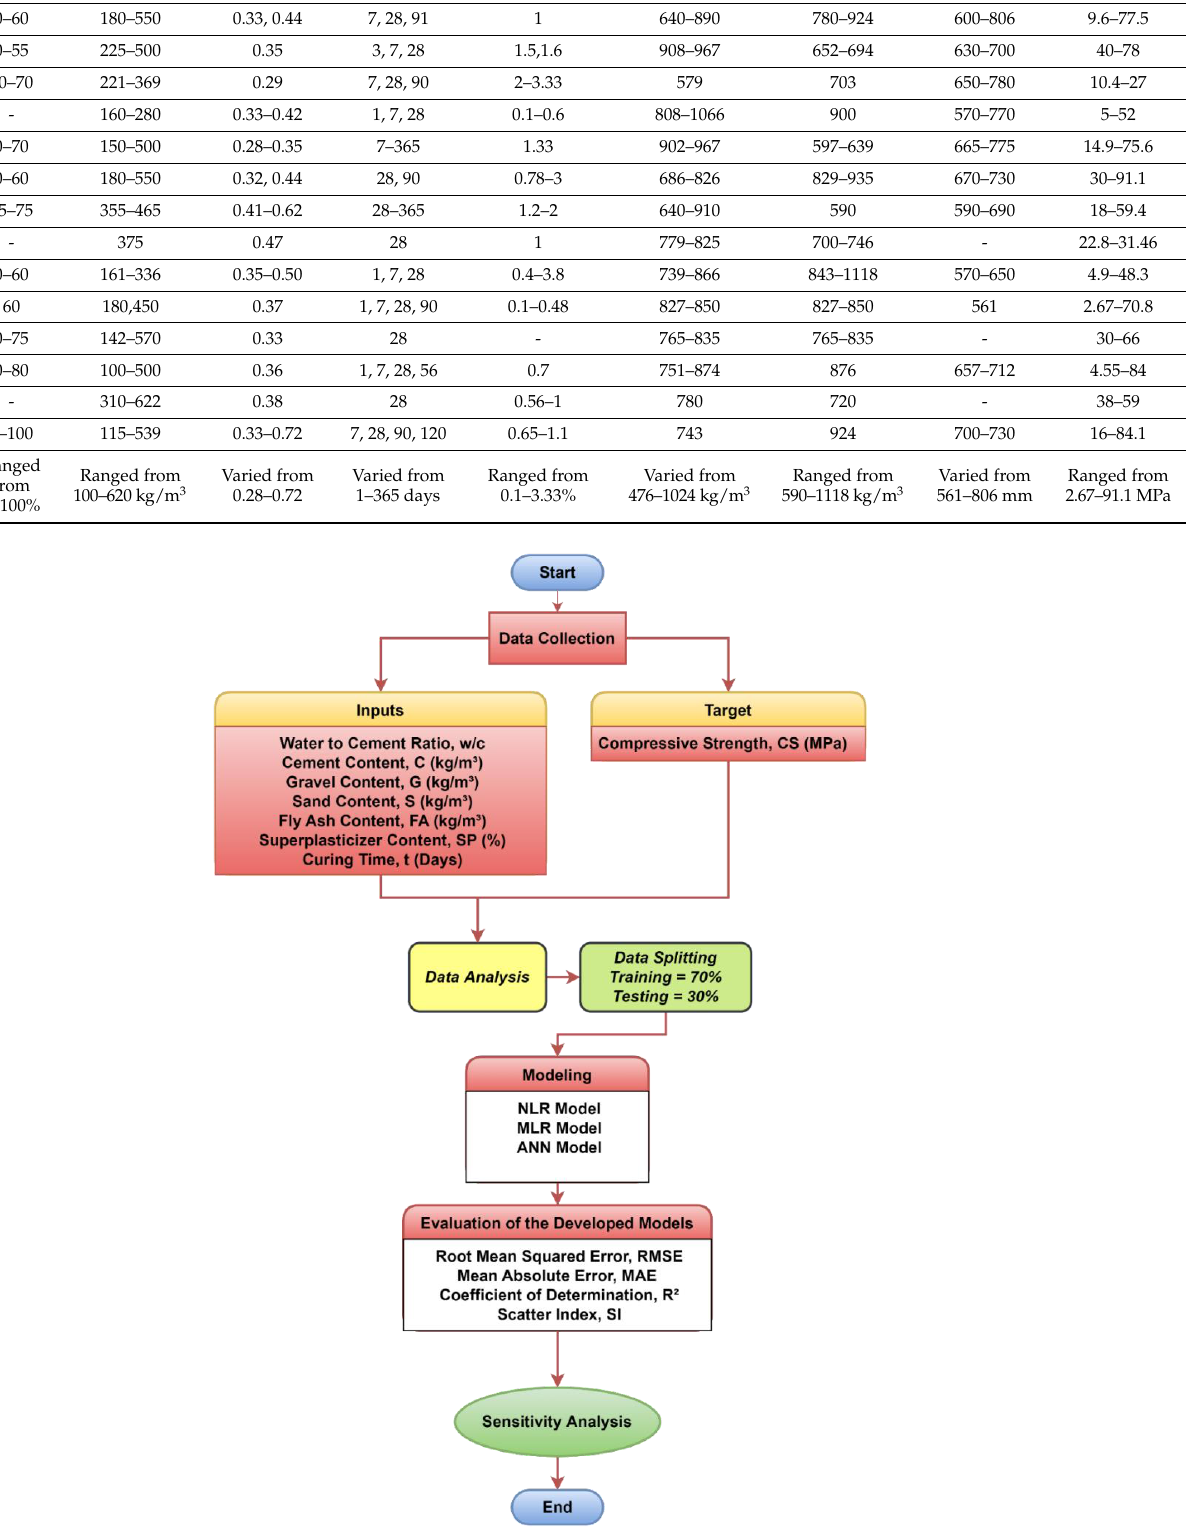
Figure 1. Current study methodology flowchart diagram.